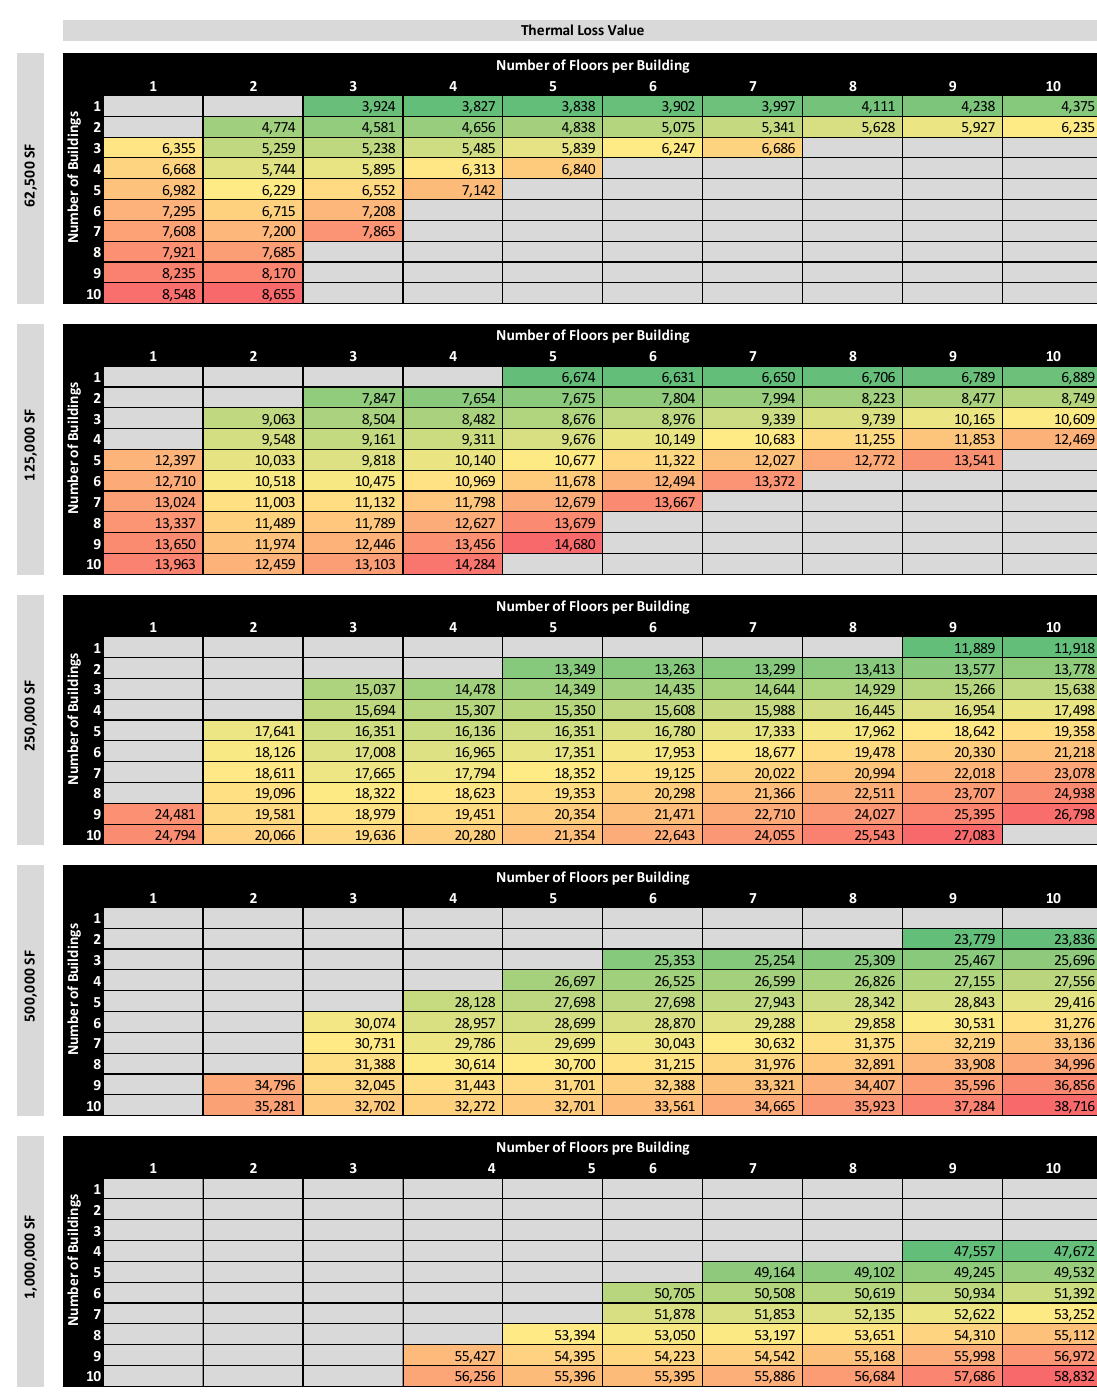
Figure 12. Thermal Loss Value by Number of Buildings and Building Height. While optimal costs were achieved with a high number of short buildings, optimal envelope thermal efficiency is achieved with a low number of taller structures. For example, for 250,000 square feet of complex floor area, the optimal envelope configuration is a one (1), nine-floor building. This contrasts with the three (3) three-story buildings that were optimal from a cost perspective. Once again, the conclusion of the model confirms the importance of compactness when considering envelope thermal efficiency. The model prefers small numbers of large buildings because these solutions result in the lowest surface-to-volume ratios,